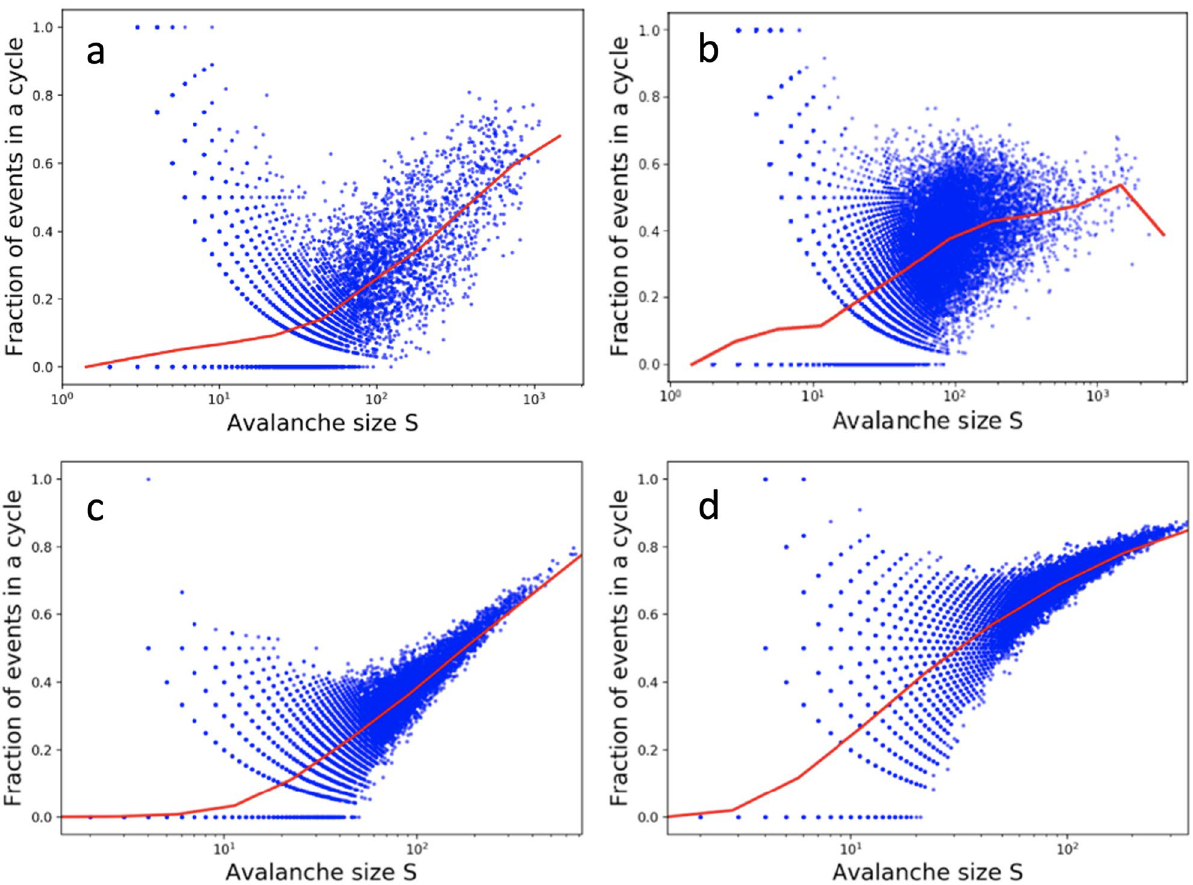
Figure 4. Fraction of firing events that lie on a cycle of activity, as a function of overall avalanche size S , for mouse experiments ( a ), rat experiments ( b ), mouse simulations ( c ) and rat simulations ( d ). By detecting cyclical activity of firing events on directed causal paths (see text), all firing events are classified as either lying on a cycle or not. For each model simulated avalanche, the fraction of firing events in a cycle for that avalanche is plotted as a function of avalanche size. Large avalanches are characterized by more recurrent firing, and a greater fraction of firing lying on cycles. Blue dots represent individual firing events within an avalanche, and the red lines represent the mean fraction of events in a cycle for all avalanches within a corresponding size